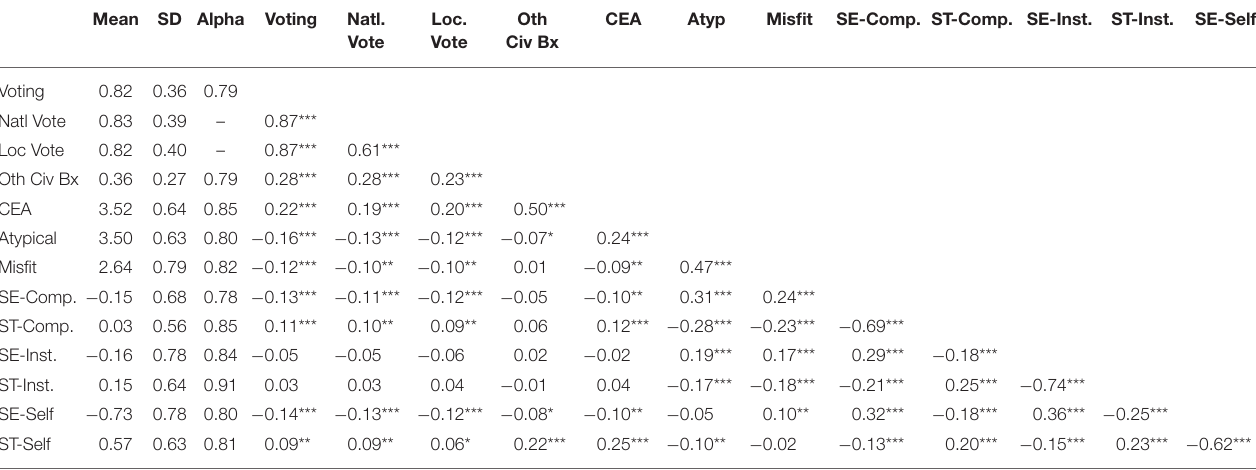
TABLE 2 | Descriptive statistics, Cronbach’s alphas, and correlations for study 2